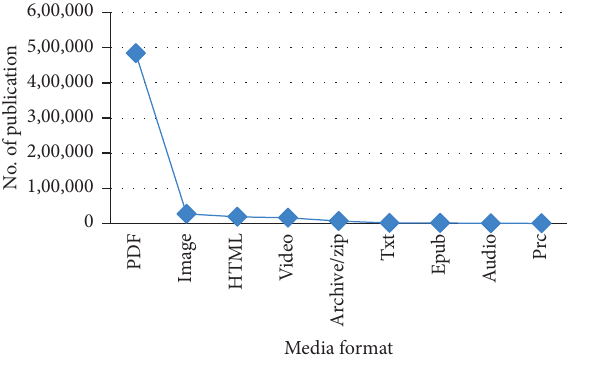
Figure 4: Total number of papers published along with the media forma.